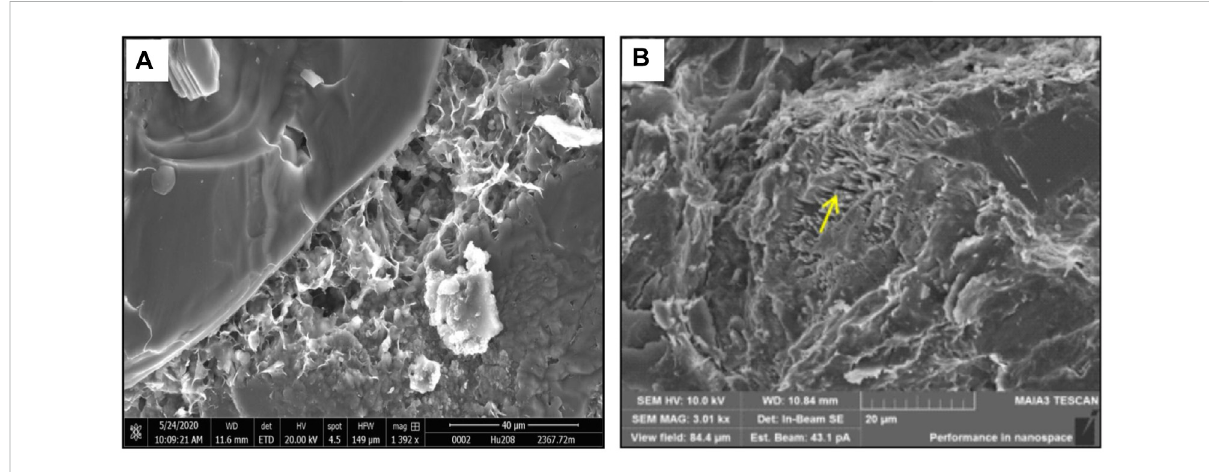
FIGURE 6 Developmentcharacteristicsofclaymineralintercrystallineporesanddetritaldissolutionporesinthetargetlayer.Notes: (A) WellX1,2367.72